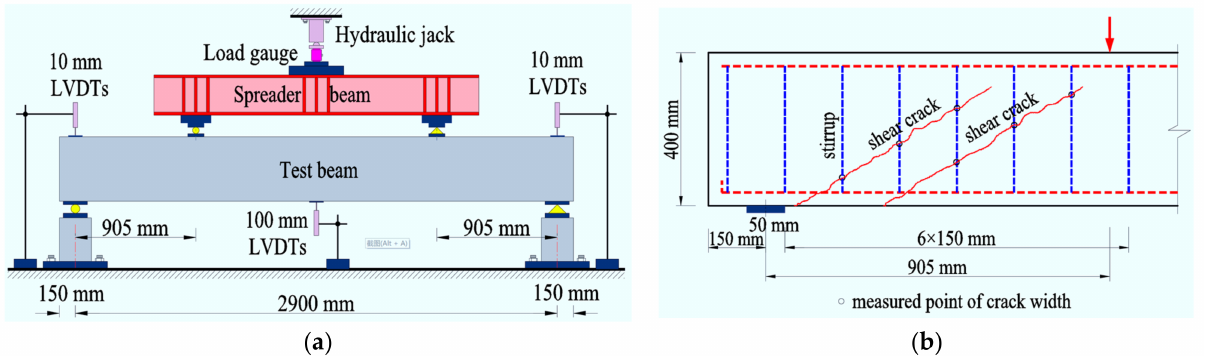
Figure 2. Test method: ( a ) testing apparatus; ( b ) measuring of shear crack width. Load gauges were linked to the hydraulic jack to measure the values of loads. The mid-span deflection was determined by three displacement sensors (LVDTs-linear variable differential transformer) placed at the supports and mid-span section of the test beam. The width of the shear crack on the side surfaces that intersected the stirrups of the test